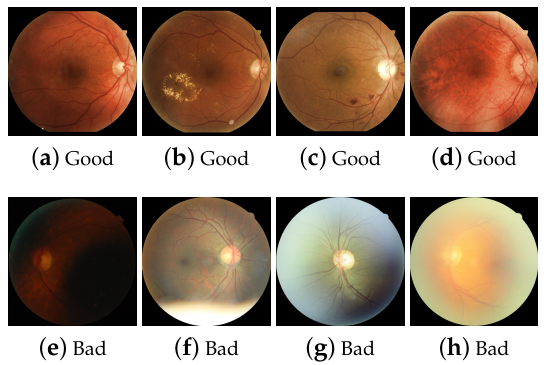
Figure 5. Examples of human labeling based on visual content considerations, ( a ) visible OD, macula, and vessels, ( b ) visible exudates, ( c ) visible hemorrhages, ( d ) visible neo-vessels and capillaries, ( e ) dark image, ( f ) flash artifact, ( g ) macula not visible and flash artifact, ( h ) blurred